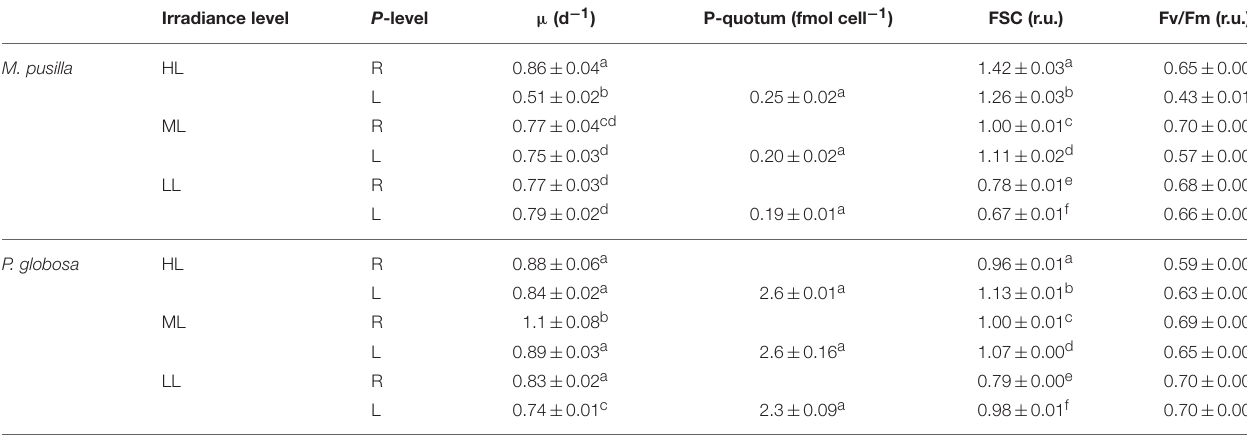
TABLE 1 | Steady state parameters of M. pusilla and P. globosa under P-replete (R) and P-limited (L) growth conditions and 3 different light conditions (250, 100, and 25 µ mol quanta m − 2 s − 1 , represented by HL, ML and LL, respectively): Average growth rate ( µ d − 1 ), mean forward scatter (FSC),